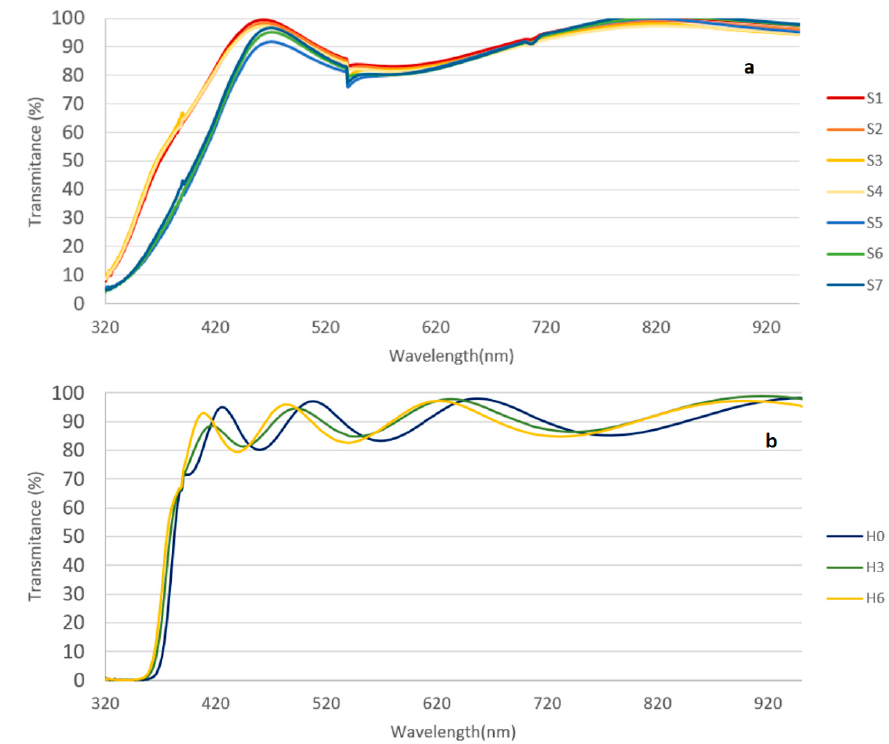
Figure 8. The UV-Vis spectral analysis of the samples in % transmittance is presented. ( a ) IZO samples; from 320 to 470 nm, the samples coated under Ar + H gas demonstrate a wider transmittance range compared to the ones coated under Ar only. From 470 to 1000 nm, all samples demonstrate similar transmittance values. ( b ) ZnO samples; these demonstrate similar transmittance however showing a wider transmission window compared to the IZO based samples.